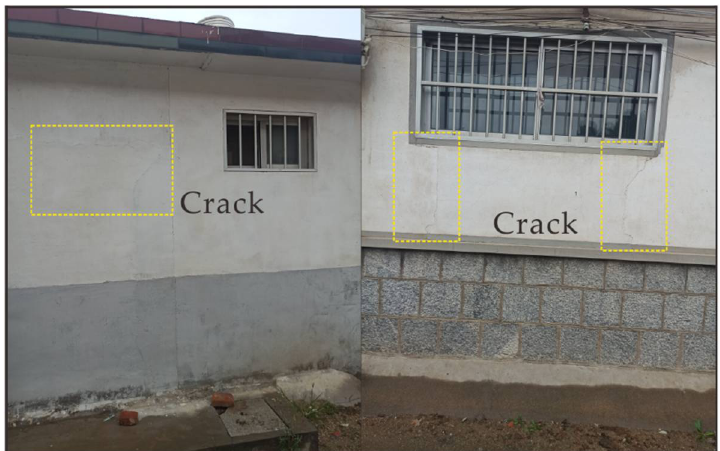
Figure 17. Construction damages due to the mining subsidence (the yellow dashed box shows the position of the cracks).